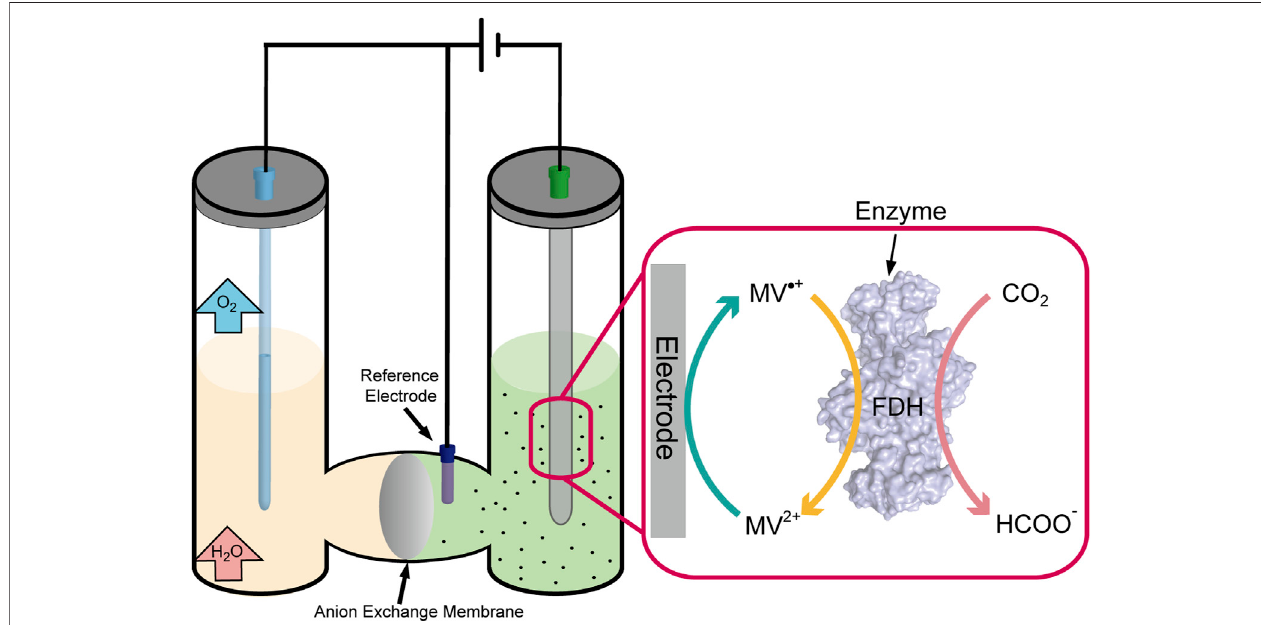
FIGURE 4 | Schematic representation of the CO 2 fi xation process by electrically driven enzyme.